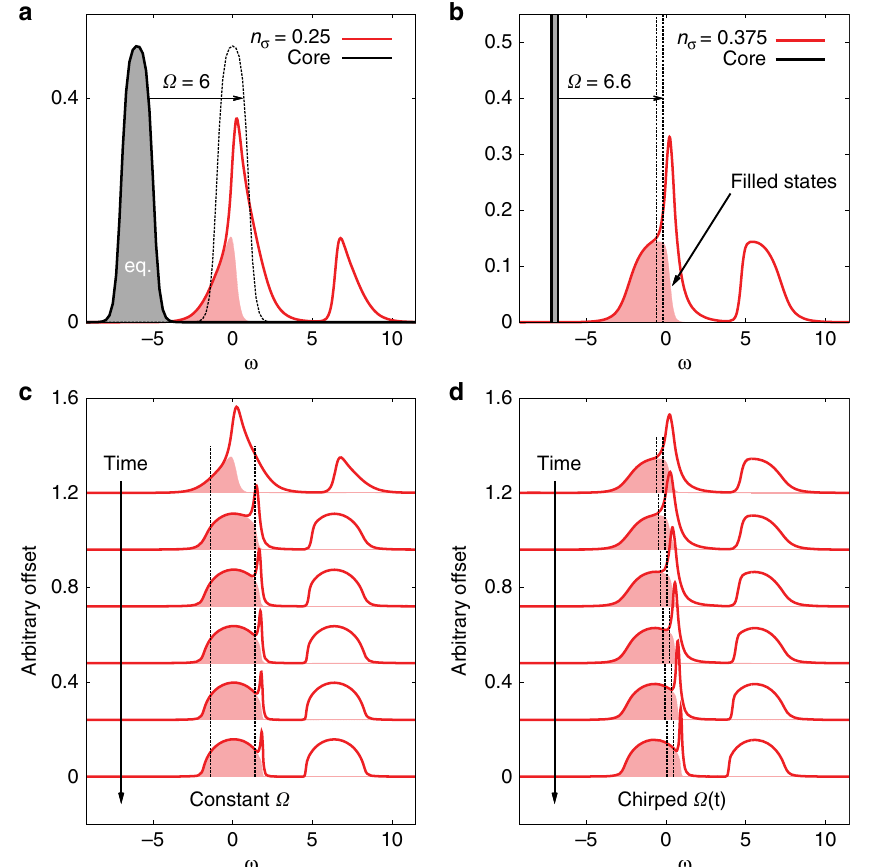
Fig. 1 Spectral functions before and after photo-excitation. Panel a illustrates the initial state in the fi rst setup: a quarter- fi lled Hubbard model (red) and core states of bandwidth 2 (black), which are treated as a noninteracting fermion bath. Panel b shows the second set-up: a 3/8 fi lled Hubbard model (red) and a narrow core band of width 0.4 (black). In both cases, the interaction parameters are U c illustrates the evolution of the spectral function (lines) and occupation (shaded region) with pulse duration in the fi rst setup, for constant driving frequency Ω ¼ 6 and amplitude a ¼ 0 : 8. Panel d shows analogous results for the second set-up and a chirped pulse with Ω max